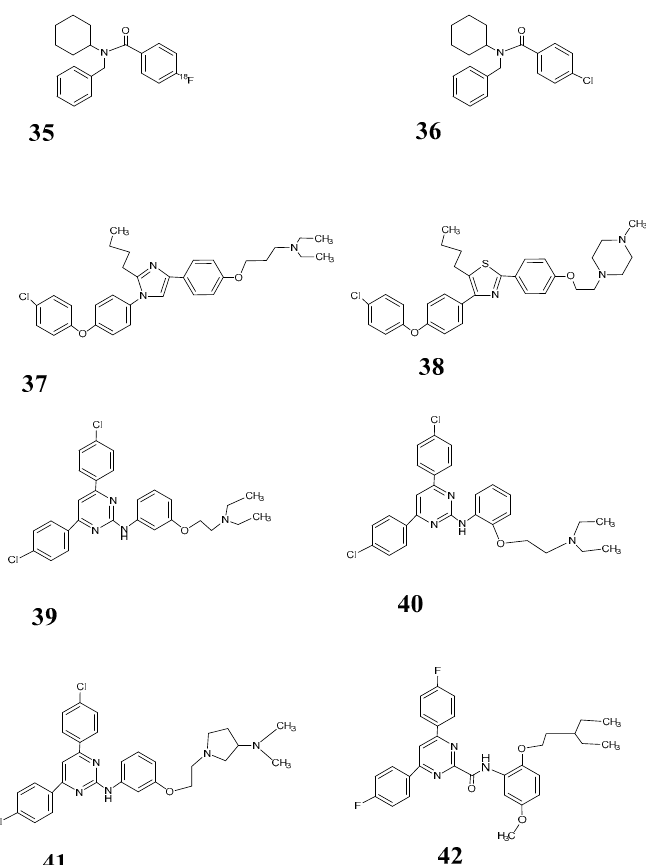
Figure 9. RAGE ligands 35 : [ 18 F] RAGER 36 : FPS-ZM1; 37 : azeliragon (TTP488); 38 : cmpd 2; 39 : cmpd 3; 40 : cmpd 4; 41 : cmpd. 5; 42 : cmpd 6.